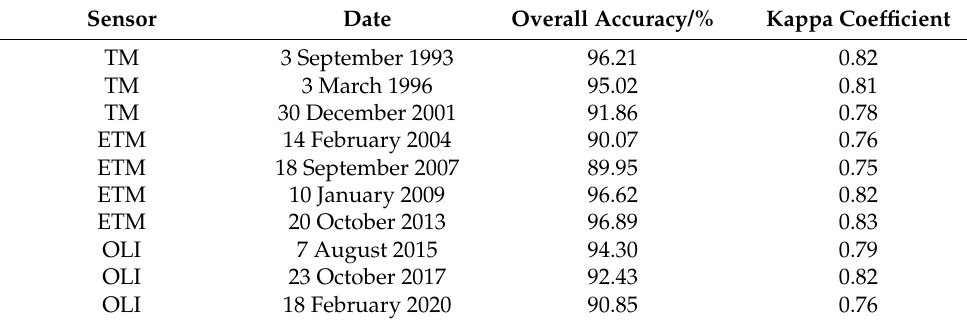
Table 2. Accuracy assessment results via visual